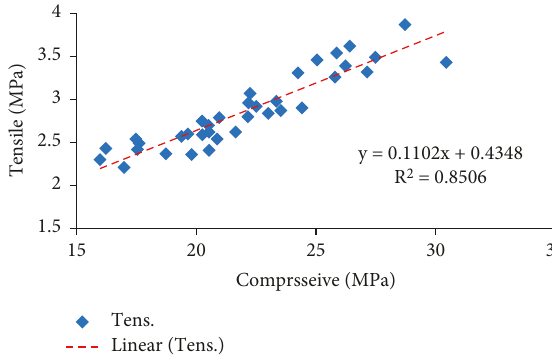
Figure 13: Relationship between tensile and compressive strength. x is the concrete compressive strength in MPa, and y is the concrete tensile strength in MPa.